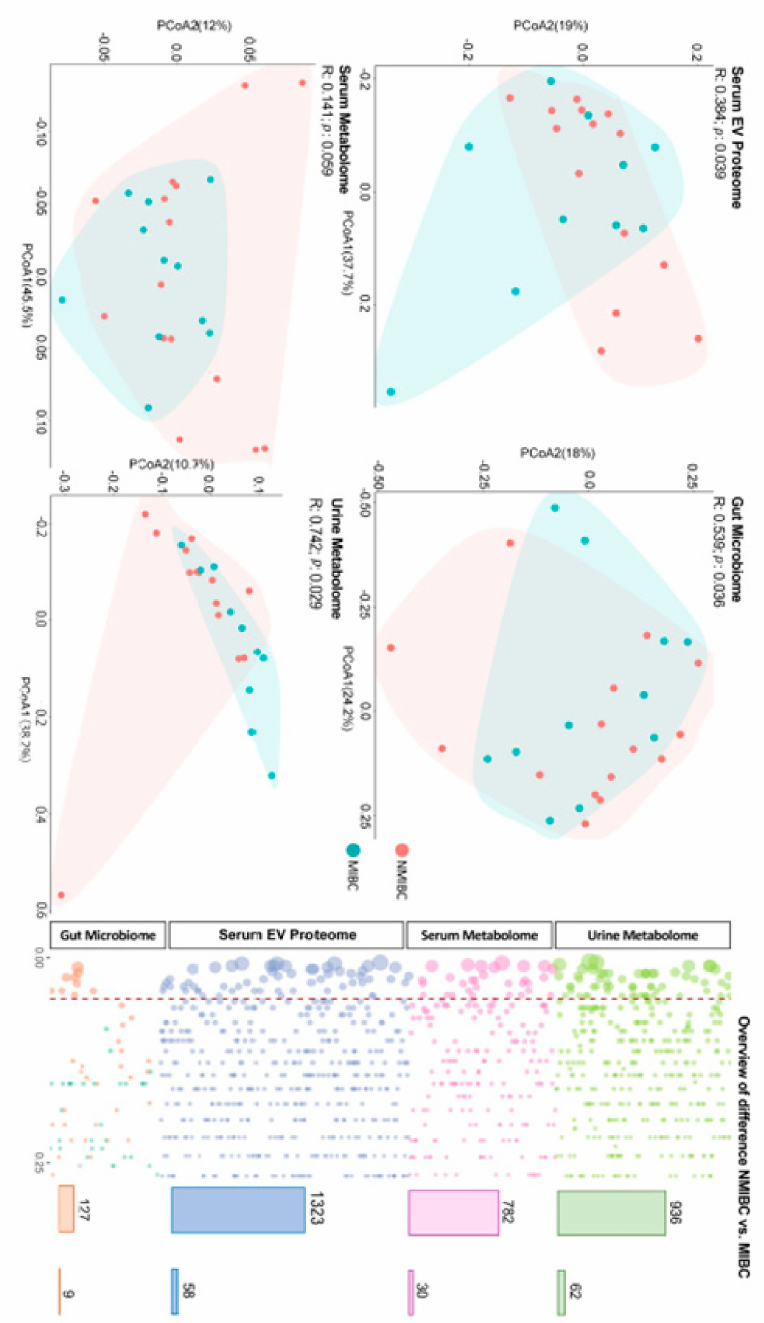
Figure 2. Global profile between NMIBC and MIBC based on multi-omics. To distinguish the molecular characteristics between NMIBC and MIBC, we measured the serum metabolome, urine metabolome, gut microbiome and serum EV proteome. We also profiled the clinical information of each participant. PCoA analysis was used, with a permutational multivariate analysis of variance, to perform the difference of global profiles. Statistical difference between two groups (NMIBC vs. MIBC) was assessed with the Mann–Whitney test. Abbreviations: NMIBC, non-muscle-invasive bladder cancer; MIBC, muscle-invasive bladder cancer; PCoA, Principal